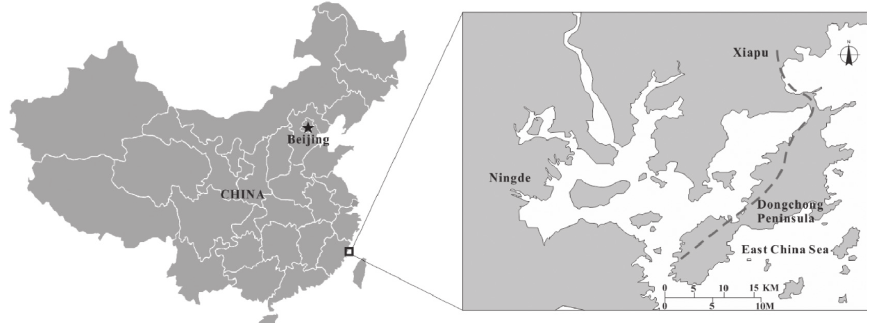
Figure 2: Location of the test site at Xia Pu, Fu Jian, China.